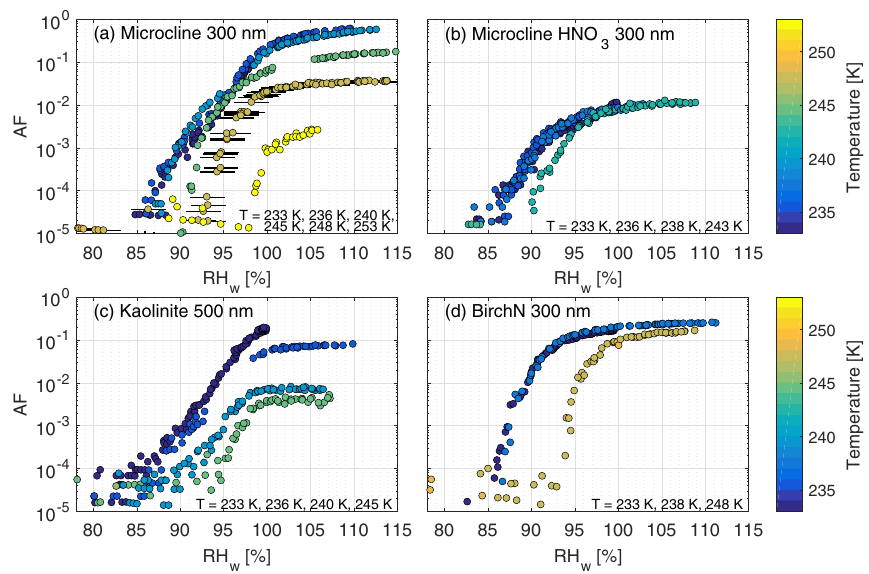
Figure 4. Activated fractions measured with PINC as a function of RH w at measured temperatures for four aerosol types: (a) untreated microcline (300nm) and (b) microcline after treatment with HNO 3 (300nm), (c) kaolinite (500nm), and (d) birch pollen washing water (birchN, 300nm). Exemplary measurement uncertainties are given for microcline (a) at 248K.